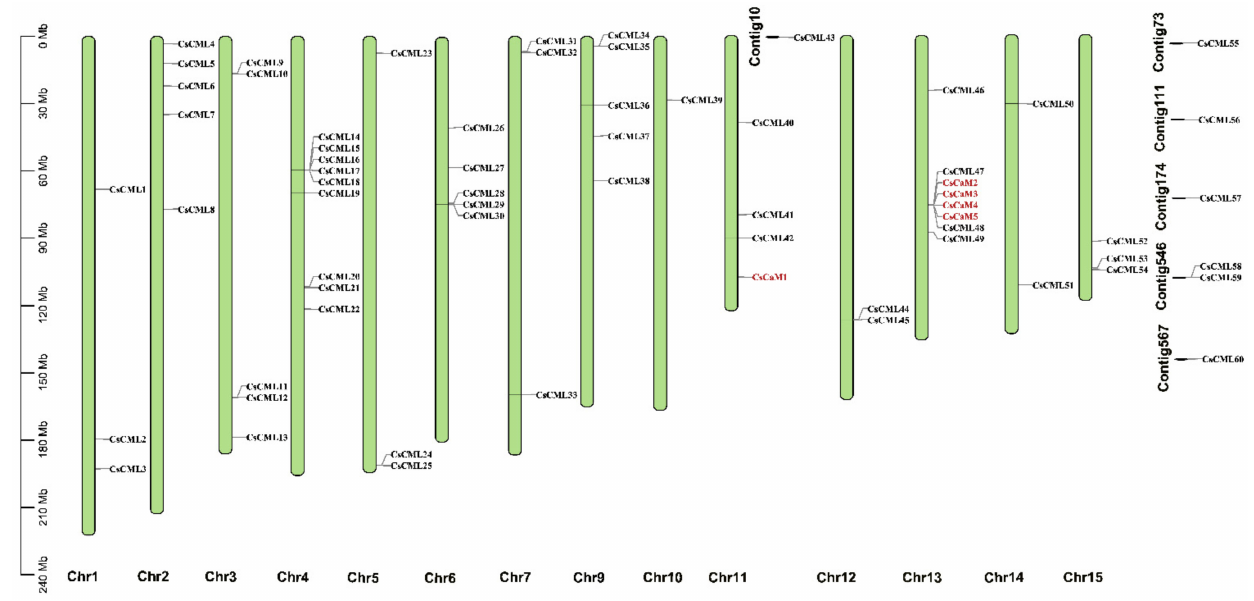
Figure 5. The distribution of CsCaM and CsCML genes in tea chromosomes. A total of 65 CsCaM and CsCML genes were mapped onto the grapevine genome. Names were assigned based on their location in tea chromosomes. The ones in red are CsCaM